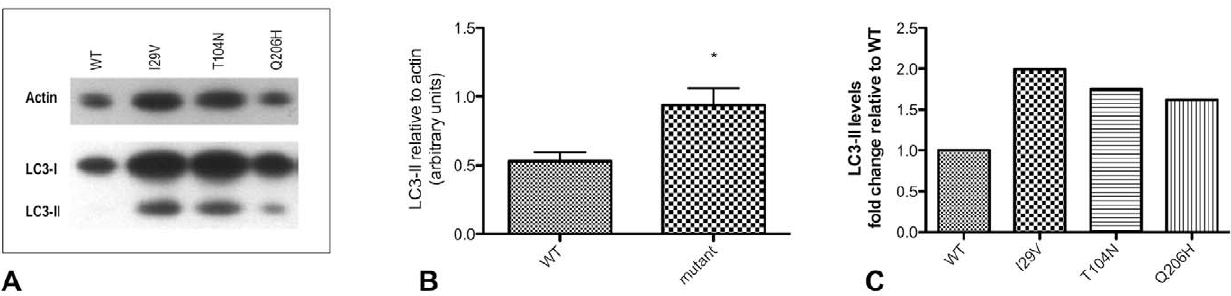
Figure 8. LC3-II levels are increased in cells expressing mutant CHMP2B. A representative image of western blotting to LC3 and actin (A), showing increased levels of LC3-II in COS-7 cells expressing mutant CHMP2B protein (lanes 2–4) compared to cells expressing wild-type protein (lane 1). LC3-II levels relative to an actin loading control were measured using densitometry (B), and this showed increased levels of LC3-II in mutant expressing cells compared to WT (mean 6 S.E.M., n=3) (Mann Whitney p=0.0242). Average fold changes in LC3-II levels normalised to WT are shown for each of the three mutants (C).